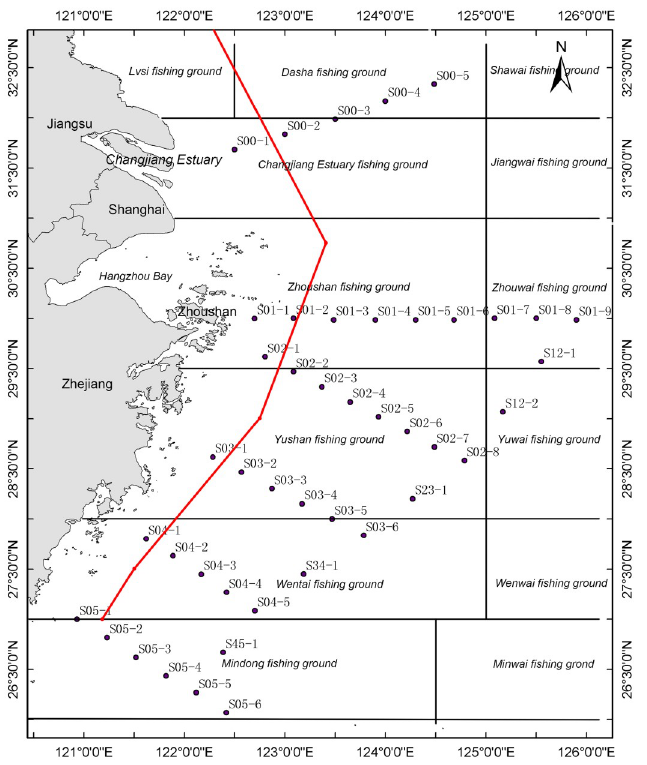
Fig 1. Map of sampling stations (black dots) of the East China Sea with adjacent provinces (Jiangsu and Zhejiang), a municipality (Shanghai), and fishing grounds (e.g., Zhoushan fishing ground) denoted. The red line indicates the nearshore areas where fishing is banned with motor